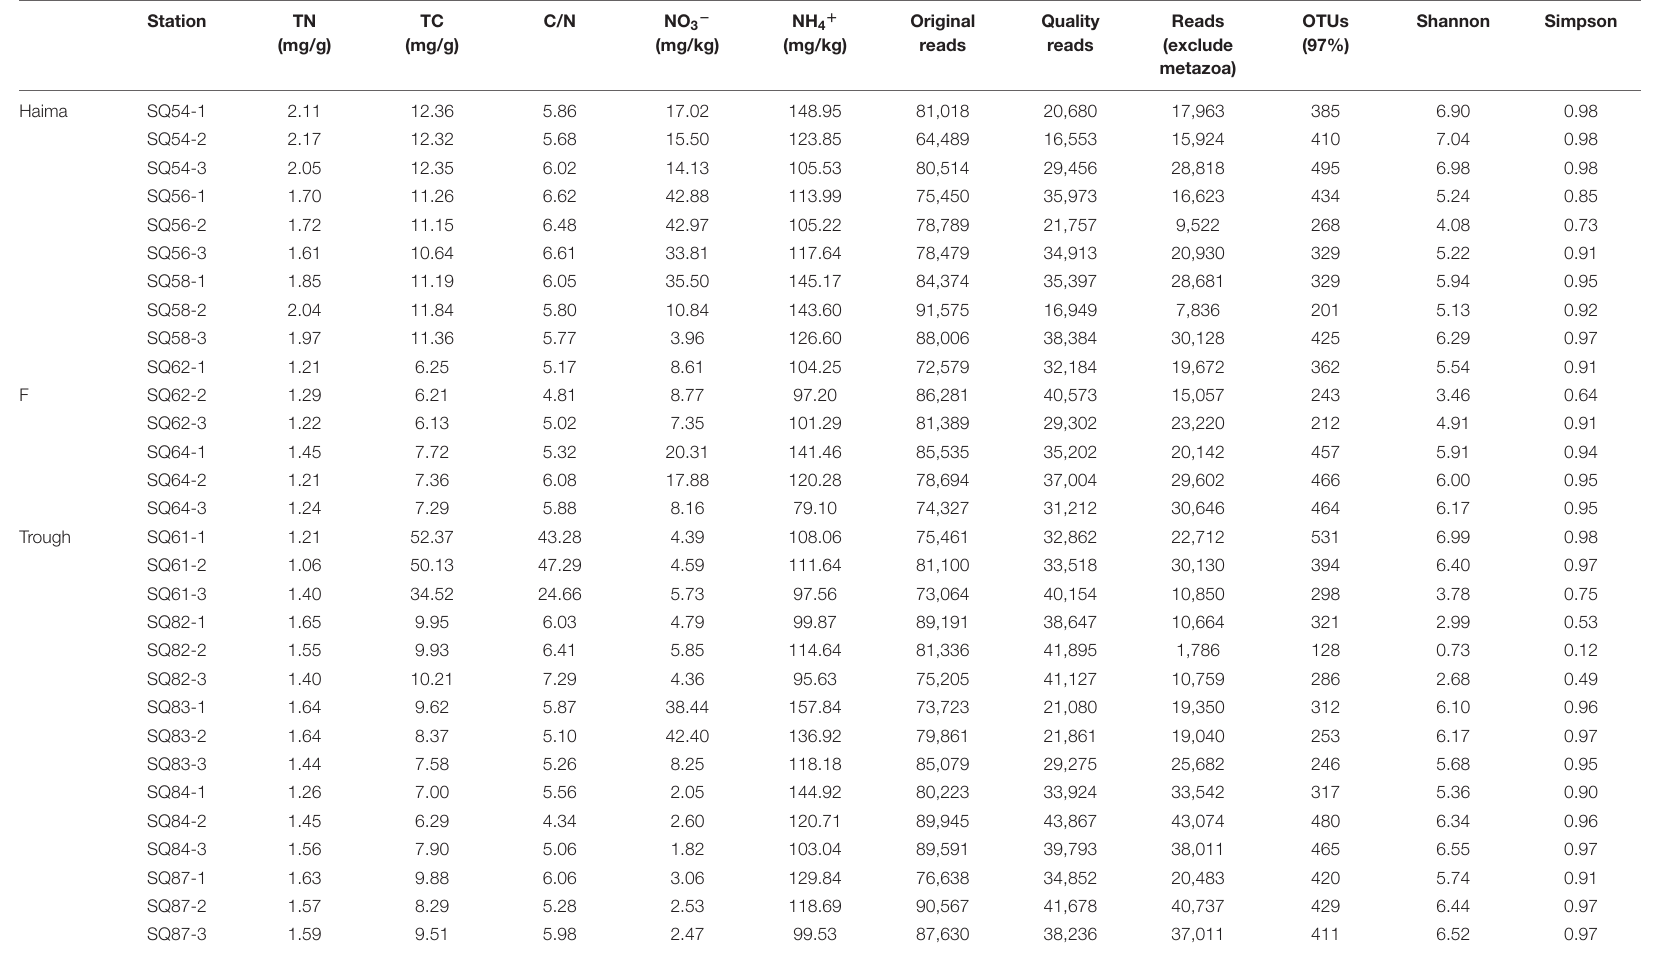
TABLE 1 | The environmental parameters, sequencing information and diversity index of sediments collected from the cold seep and trough sampling sites in the northern South China Sea. Station